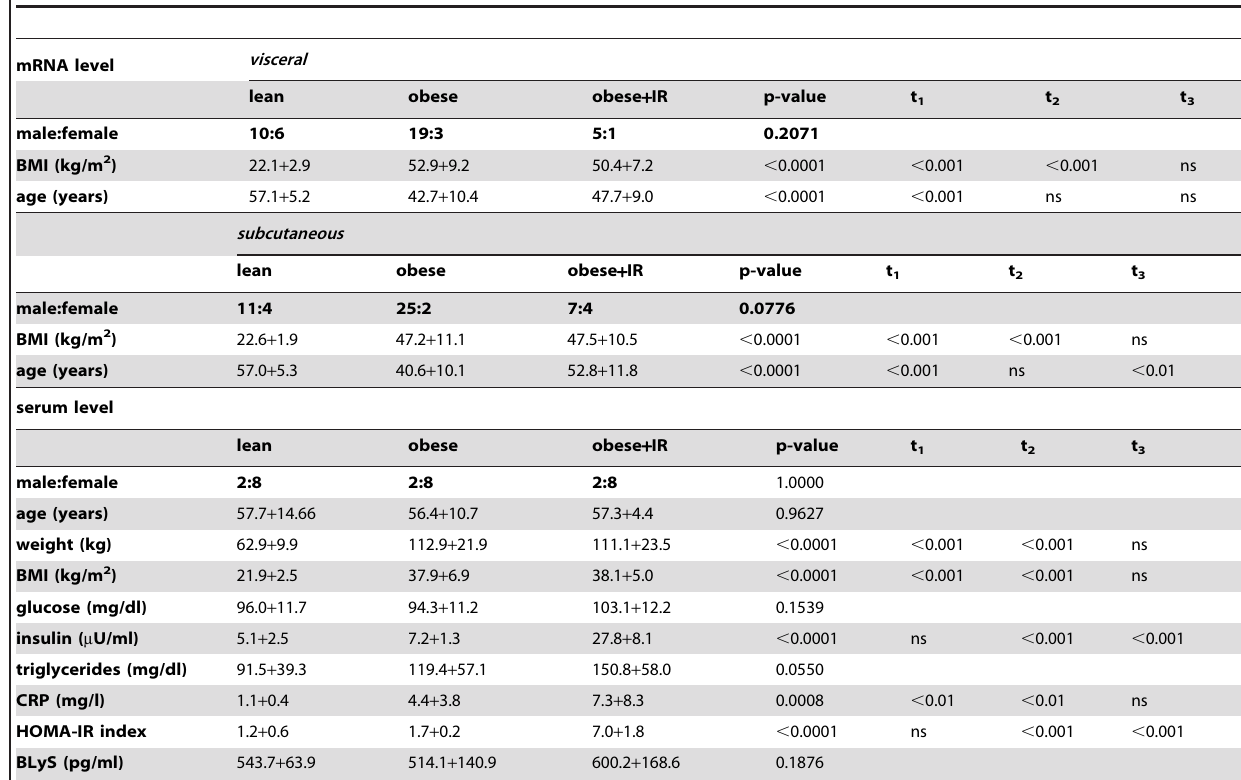
Table 1. Baseline characteristics of the study populations of the BLyS mRNA in human total adipose tissue biopsies of lean, grade 3 obese + / 2 insulin resistance (IR) and of BLyS measurements in sera of lean, grade 1 + 2 obese + / 2 insulin resistance.